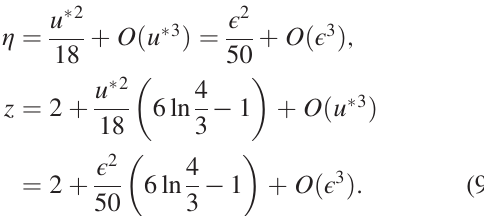
FIG. 6. Two-loop RG beta function 9 β R the renormalized nonequilibrium parameter r KR , Eq.